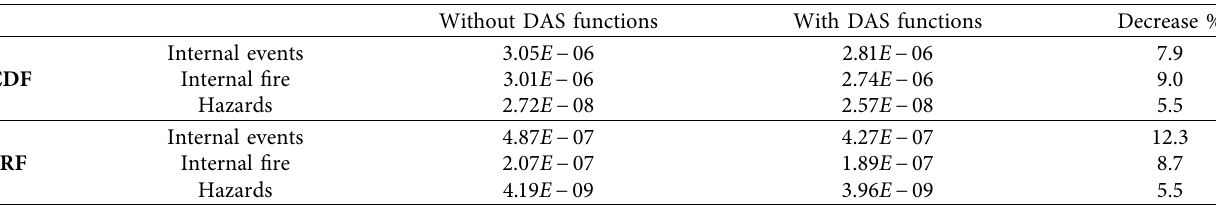
Figure 1: Trends of critical parameters after SLB concurrent with RPMS failure. Table 4: Insight of